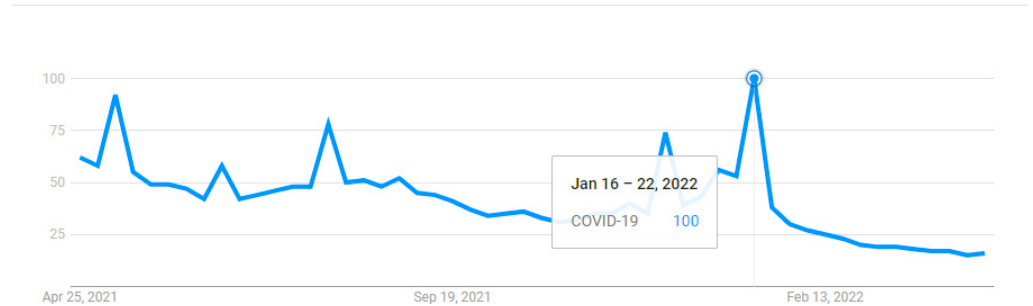
Figure 2. Google trends of research interest related to COVID-19 pandemic.